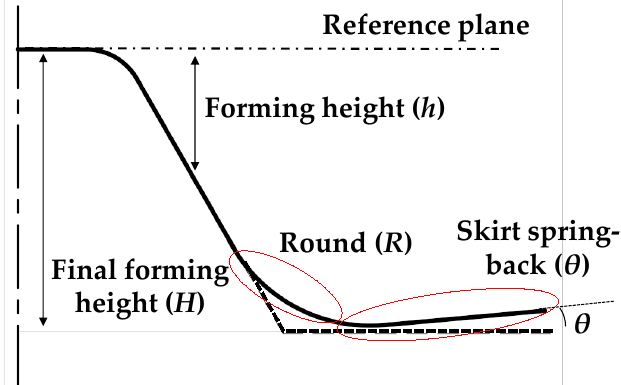
Figure 4. Definition of the shape error.